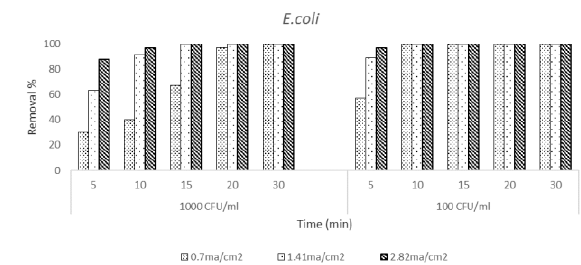
Fig.2a Percentage of live bacteria after electrochemical disinfection containing steel mesh electrode Escherichia coli